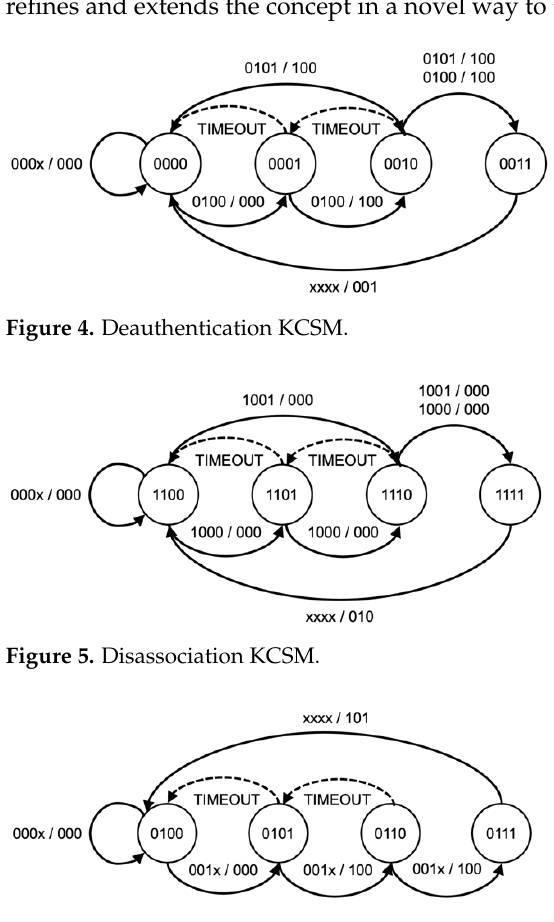
Figure 7. Association flood KCSM. The sequence and status of each attack kill chain are stored in a set of state machines accessed via a P4 support API function. The state of each attack is stored on a per-client basis allowing for the processing of concurrent attack phases. This method enables the WAP to track and counteract multiple attacks of different types or even attacks that may simultaneously target some or all client devices. This algorithm synchronizes each wireless client’s state to detect coordinated attacks intelligently. The memory footprint and processing requirements are minimal, utilizing only 512 bytes of state memory. Each state sequence is based upon a kill chain model of the attack sequence and customized to allow for timing between states and variations due to wireless anomalies, such as dropped or corrupt frames. As each kill chain is different, the state model will be explained in further detail in the evaluation section below. 2.4. Countermeasures